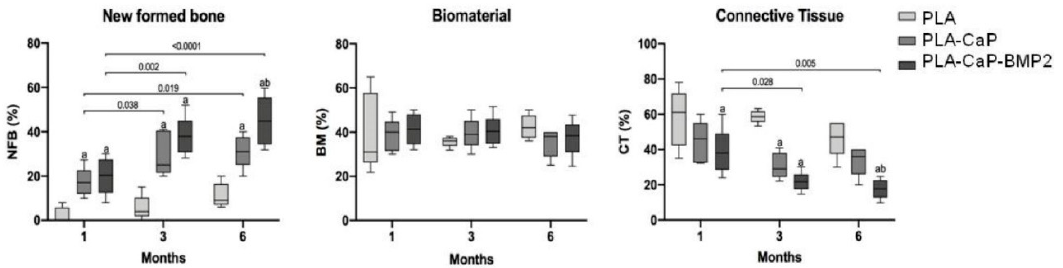
Figure 13. Box plot comparing the volume of new formed bone (NFB), biomaterial (BM) and connective tissue (CT) (%) of PLA, PLA-CaP and PLA-CaP-BMP2 groups (n = 5) after experimental periods. Horizontal bars represent statistical differences between same group at different experimental periods and its respective p values. (a) represents significant statistical differences compared to PLA group. (b) represents significant statistical differences compared to PLA-CaP group (ANOVA and Tukey post-test, p < 0.05).